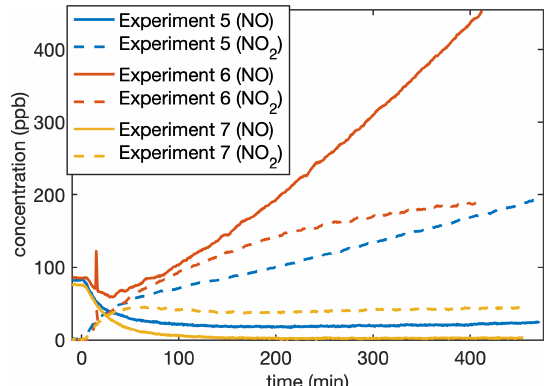
Figure A2. For the experiments that included NO x , the NO and NO 2 concentrations as a function of the time since the onset of ox- idation. C8 is not included, since methyl nitrite was present. The measurement uncertainty is ∼ 5ppb, but any organonitrates would also be measured as NO 2